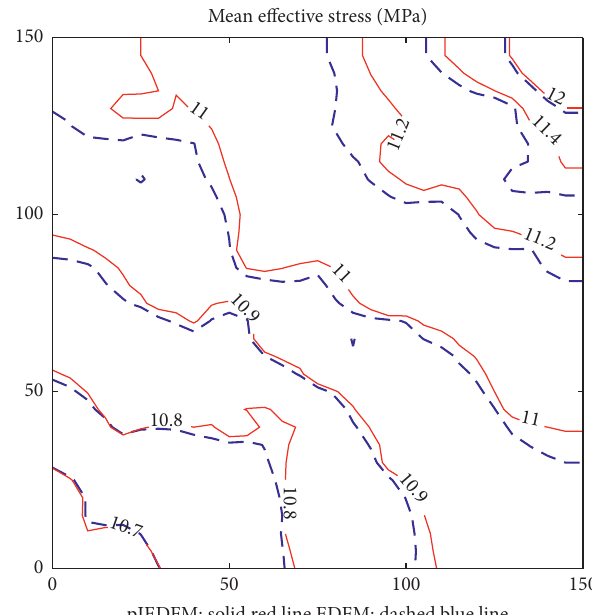
pIEDFM: solid red line EDFM: dashed blue line Figure 28: Contour map of mean effective stress field after 20000days of production.